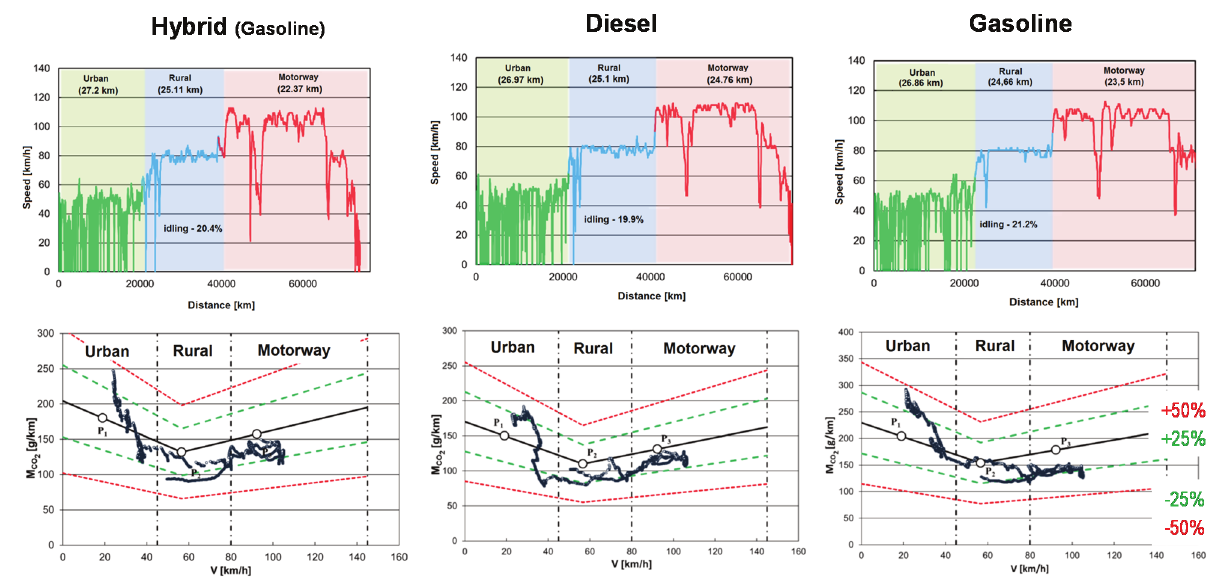
Fig. 12. Comparison of the traffic conditions for each of the tested vehicles